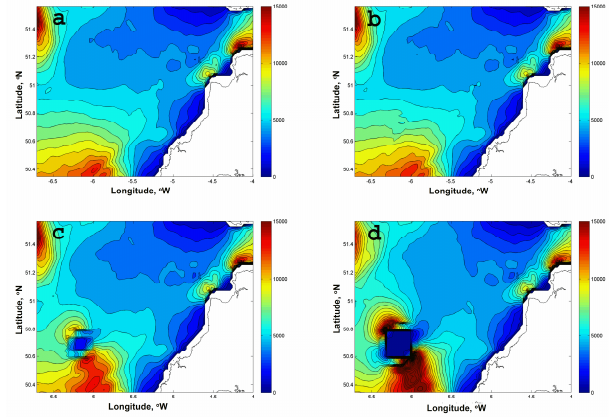
Fig.7. Simulated trajectories of Lagrangean drifters drogued at 22.5 m depth. (a) – 661 Fig. 7. Simulated trajectories of Lagrangean drifters drogued at 22.5m depth. (a) baseline case, (b) low, (c) medium, and (d) high baseline case, (b) -low, (c)-medium, and (d)-high rated power capacity farm for the 662 rated power capacity farm for the period from 00:00h 1 June to period from 00:00 hours 1 June to 13:00 hours 08 July 1998. The centre of the farm 663 13:00h 08 July 1998. The centre of the farm coincides with the coincides with the launch site of drifter #7. 664 launch site of drifter #7. 665